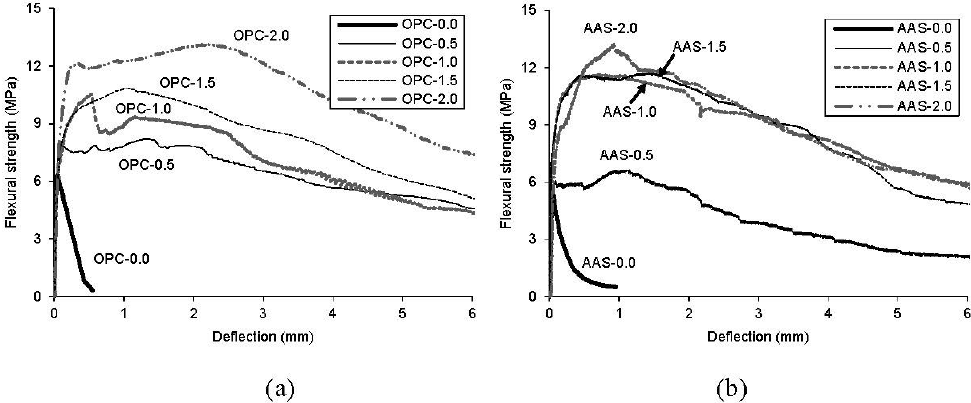
Figure 6. Flexural strength ‐ deflection curves of test specimens at 28 days. ( a ) OPC specimens; ( b ) AAS specimens.